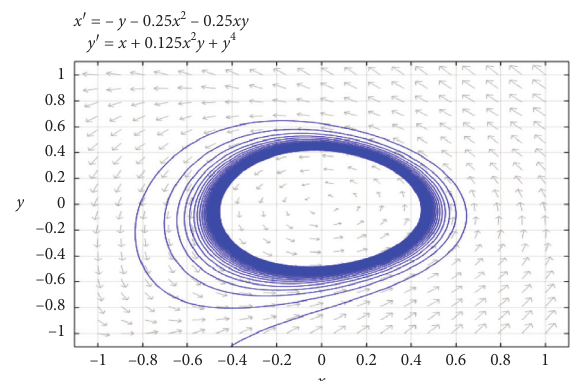
Figure 9: Existence of limit cycle of system (6), when k � − 0 . 25 ,l � − 0 . 25 ,m � 0 . 125 , and n �